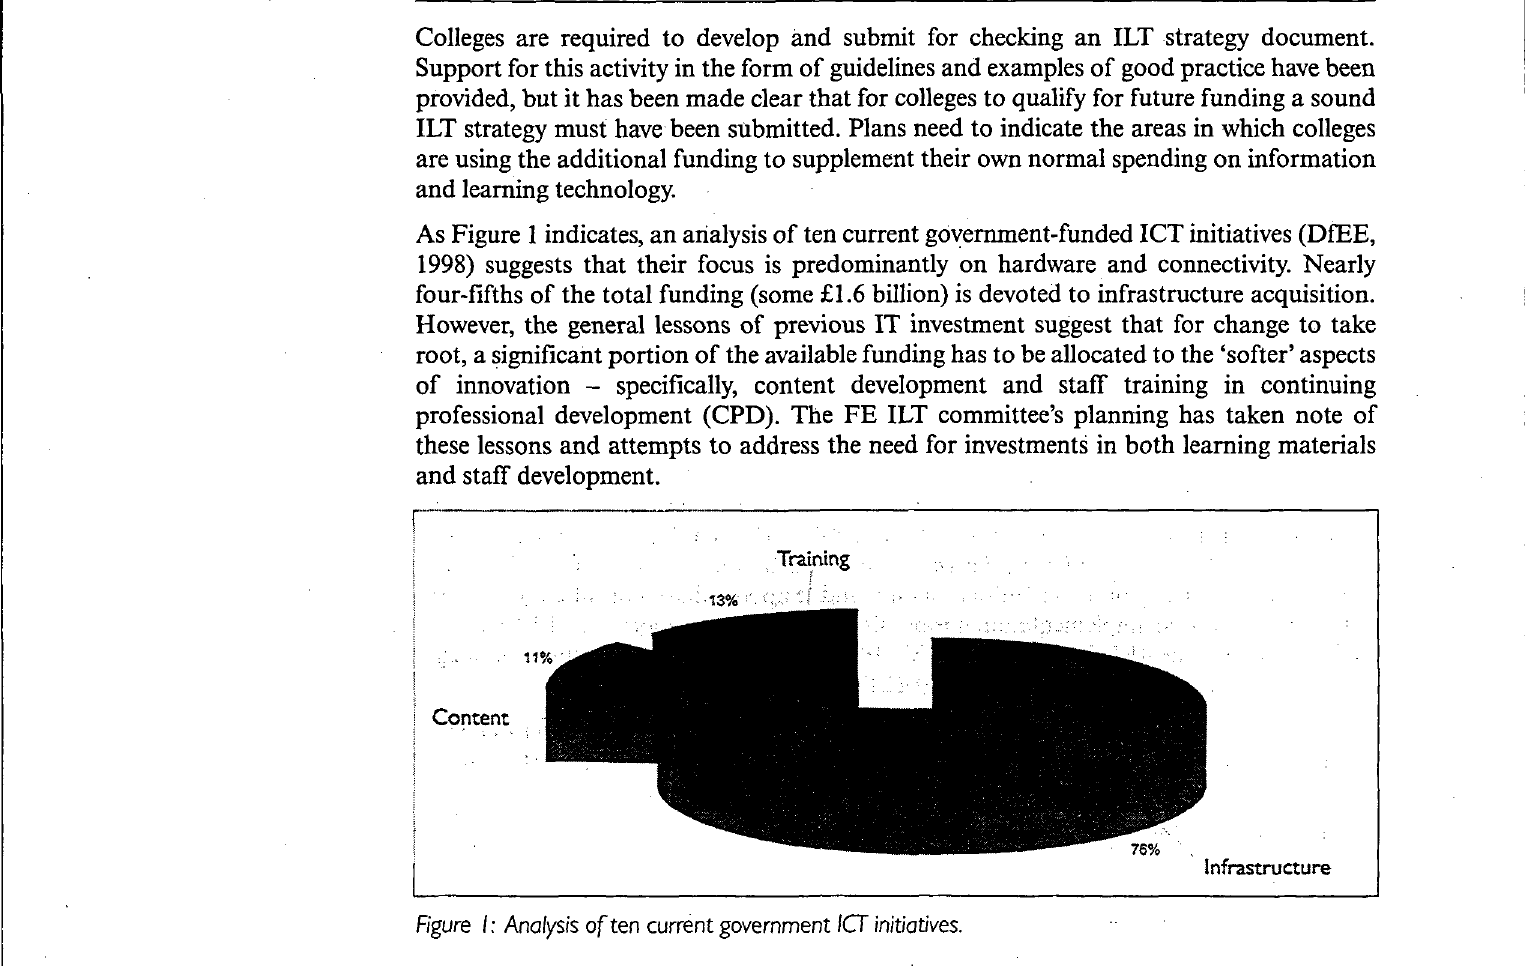
Figure I: Analysis often current government ICT